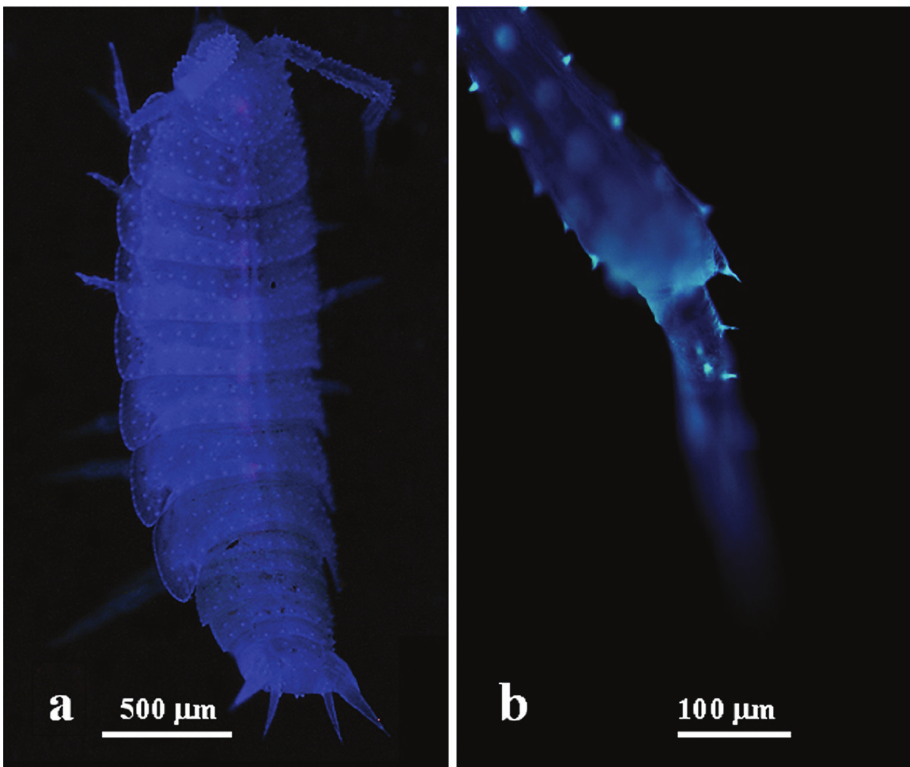
Figure 1. Autofluorescence of the body of Mesoniscus graniger under UV light. a stereomicroscope with UV-inspector 385 (excitation light 365nm) b detail of the antennae - fluorescence microscope U-MWU mirror unit (330–385